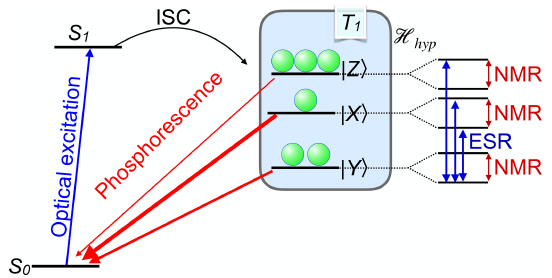
Figure 32. Optical excitation and detection of ESR and NMR tran- sitions in a molecule with a triplet